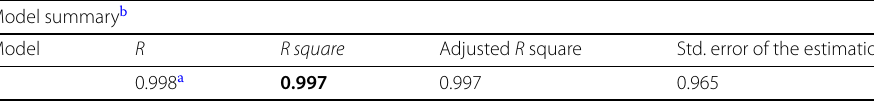
Table 8 Coefficient of determination ( R square) table of the physical and mechanical properties of breaking load-compressive strength